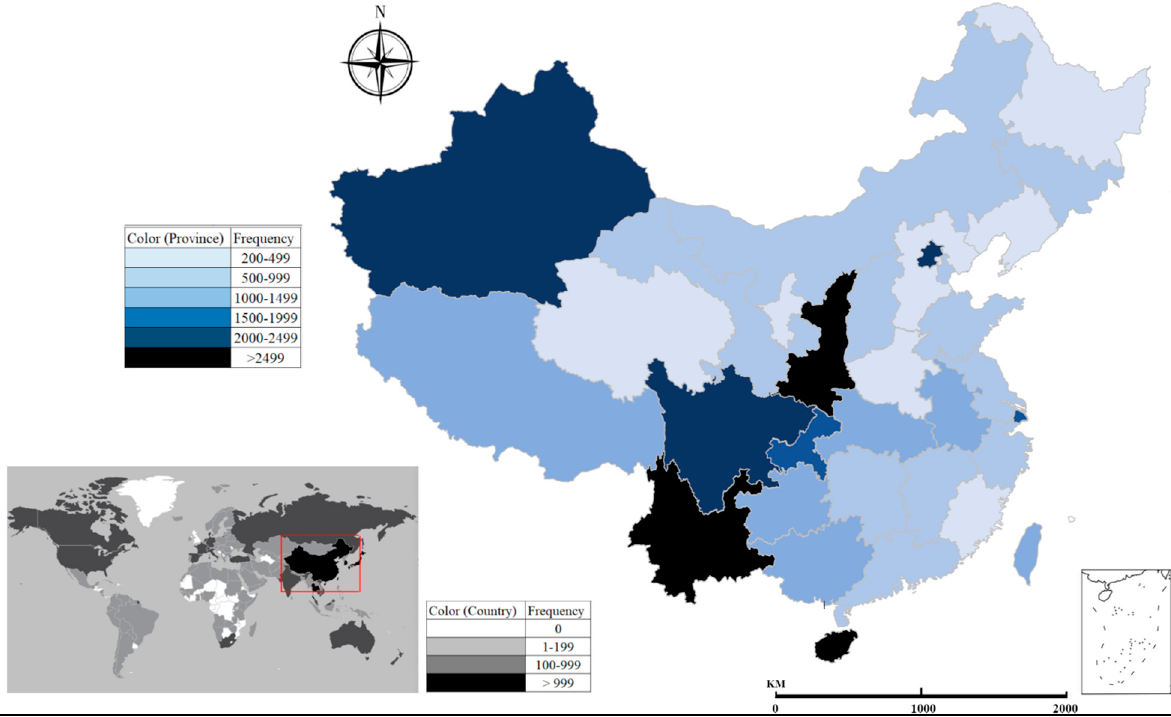
Figure 3. Spatial distribution of live streaming locations.